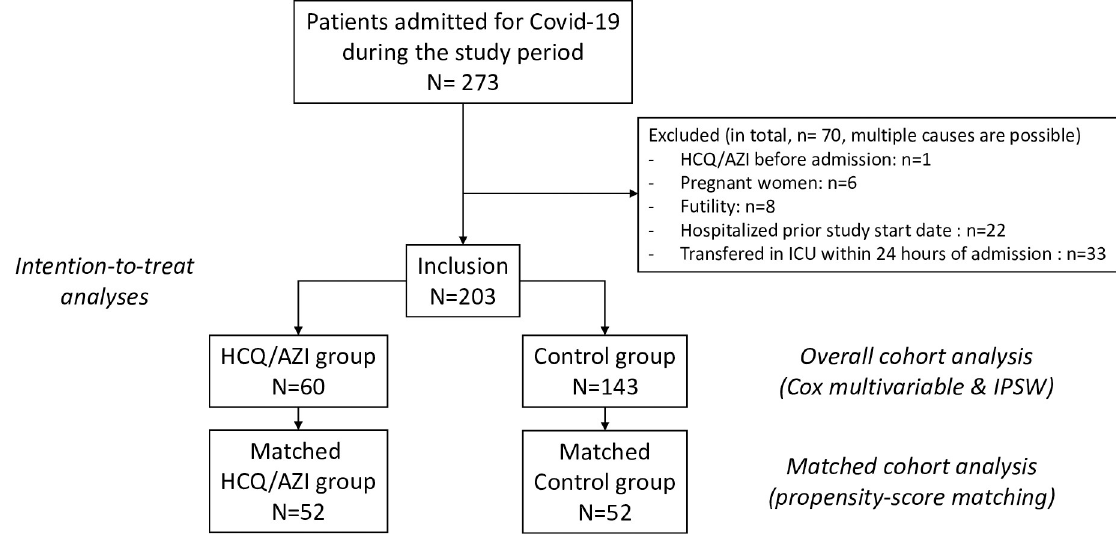
Fig 1. Study flow-chart. Abbreviations: HCQ/AZI: Hydroxychloroquine combined with azithromycin; IPSW: Inverse probability score weighted.